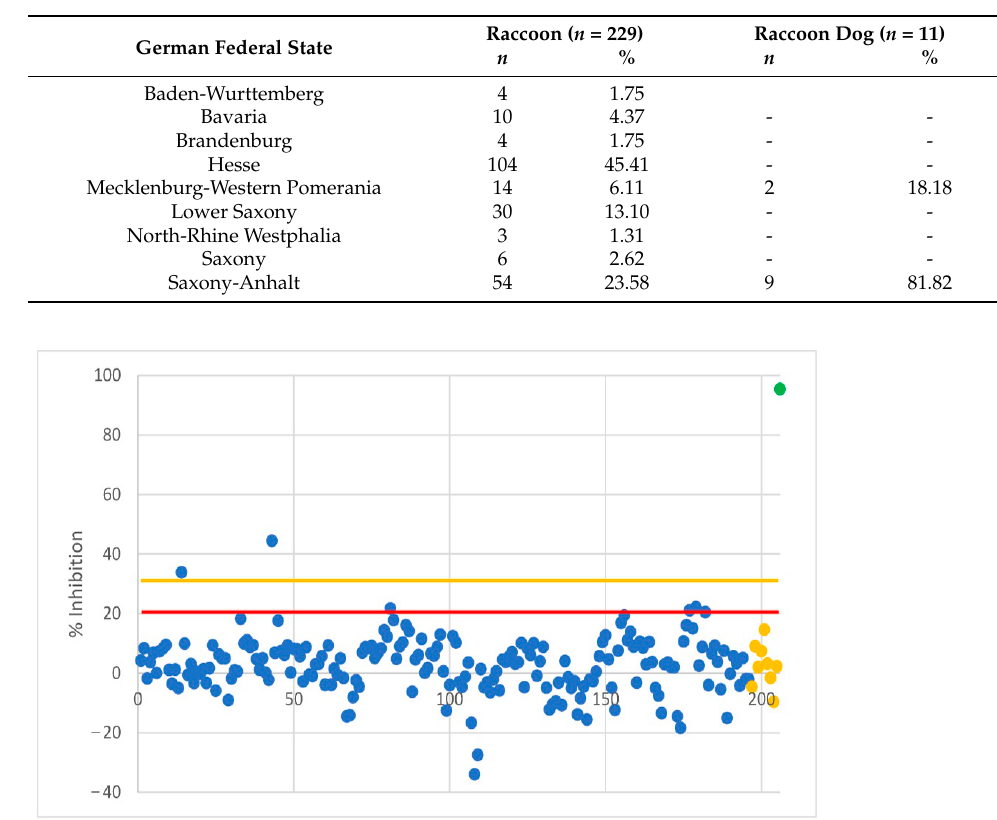
Table 1. Origin of the tested samples. Samples were collected in eight German federal states with